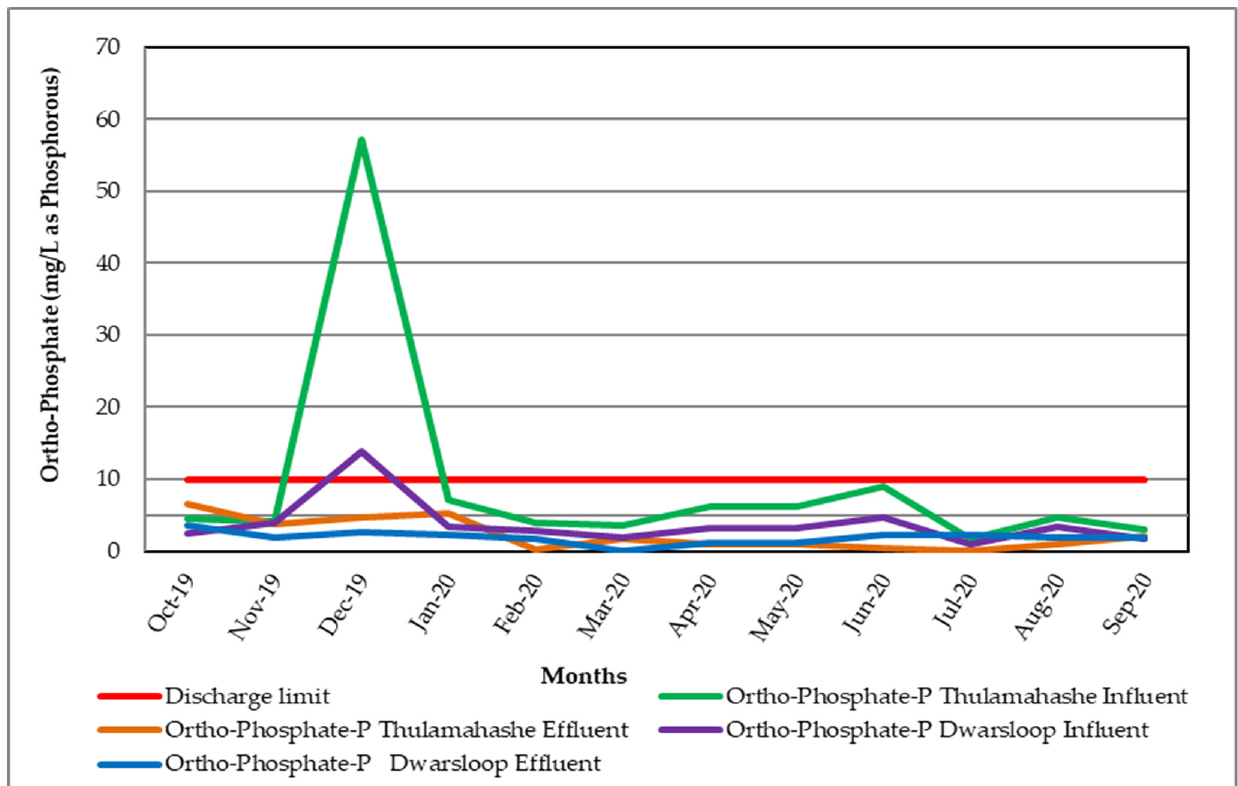
Figure 10. WWTWs performance in terms of Ortho-Phosphate. Figure 11 depicts the average COD concentrations in the Thulamahashe WWTW influ- ent and effluent, which range from 188.00 to 1057.00 mg/L and 16.00 to 76.00 mg/L, respec- tively, while concentrations in the Dwarsloop WWTW ranged from 106.00 to 1632.00 mg/L and 25.00 to 149.00 mg/L. Both wastewater treatment plants demonstrated their effective- ness in removing chemical oxygen-demanding compounds from influents, even though they did not meet the required limit. The recommended limit of COD should be 75 mg/L. COD concentrations in the Thulamahashe WWTW were above the limit throughout the study period, except for the June and July 2020 effluent, which had low concentrations of 74 and 16 mg/L, respectively. Concentrations in the Dwarsloop WWTW were low, except in February and September 2020, when they were significantly higher than the recommended limit, at 113 and 149 mg/L, respectively. Higher COD levels indicate that there is more oxidizable organic material in the water bodies, which reduces dissolved oxygen (DO) levels. A reduction in DO can lead to anaerobic conditions, which are harmful to higher aquatic life forms, and the COD is an important water quality parameter because it provides an index to assess the impact of discharged wastewater on the receiving environment